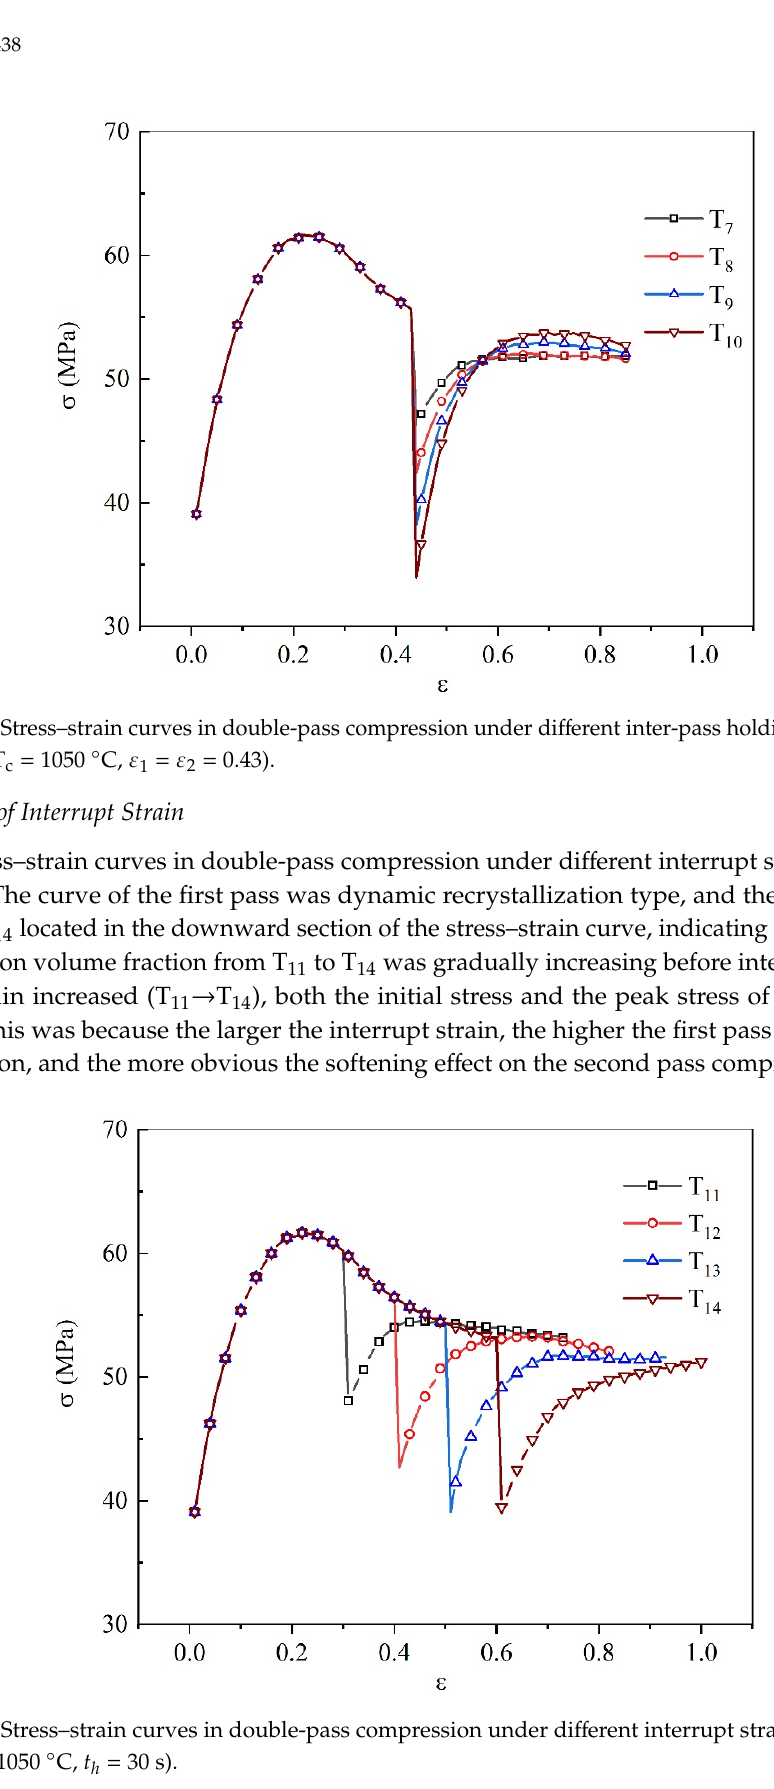
Figure 5. Stress–strain curves in double-pass compression under di ff erent interrupt strains ( (cid:2013) (cid:3030) ̇ =0.01 s − 1 , T c = 1050 ◦ C, t h = 30 s).